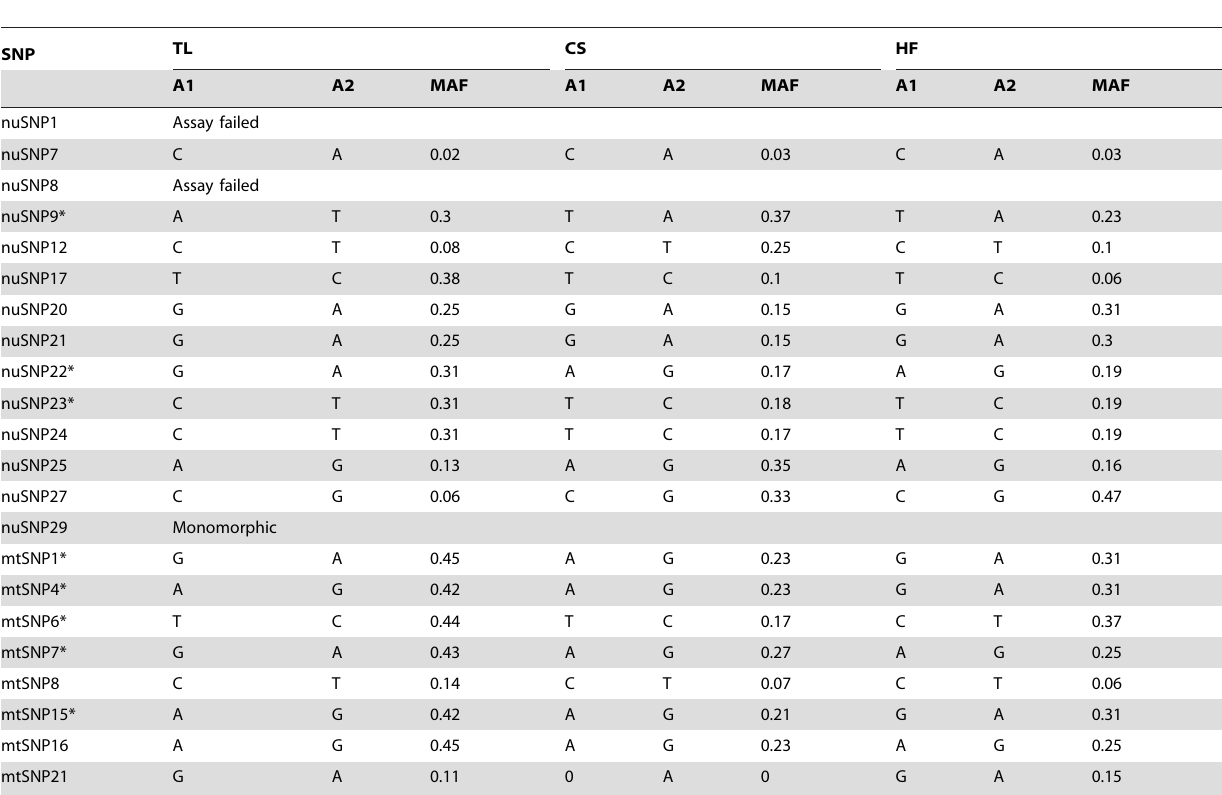
Table 7. Polymorphism of significantly associated/linked markers to growth traits in three aquaculture